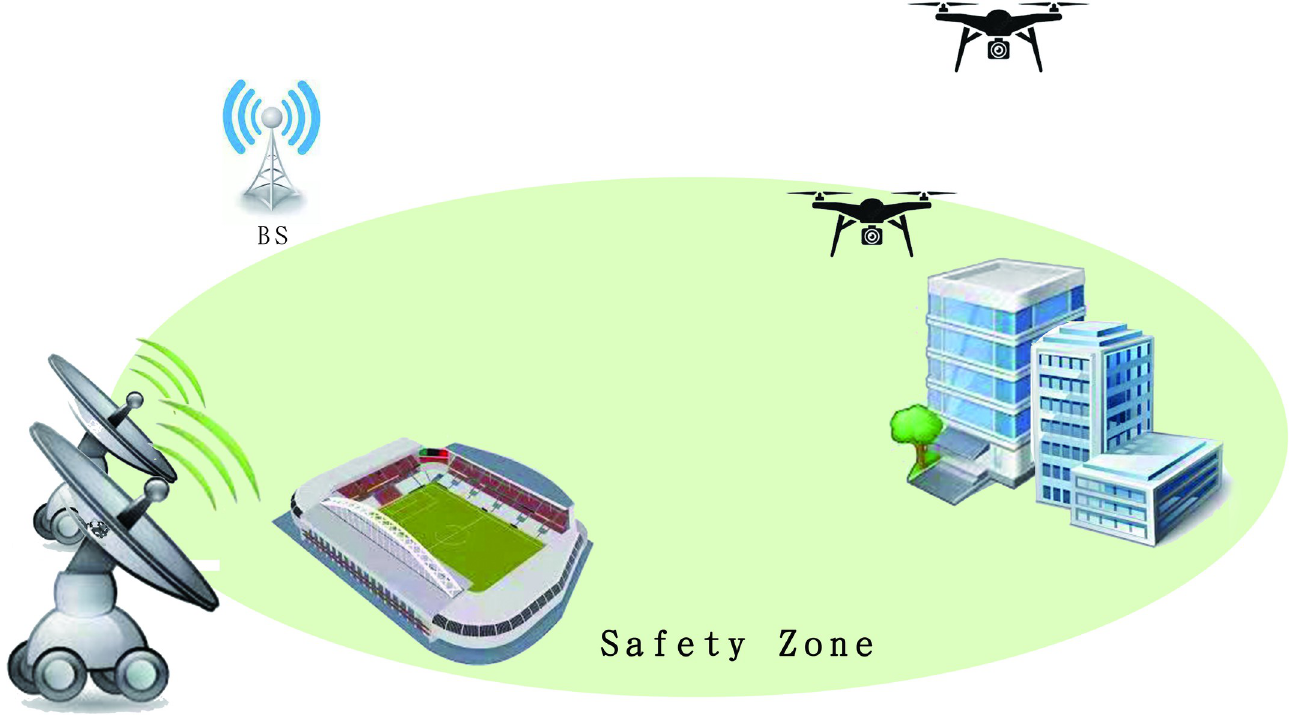
Fig 1. Spectrum sharing for massive MIMO radar and drones detection entering safety zone on brownian motion.